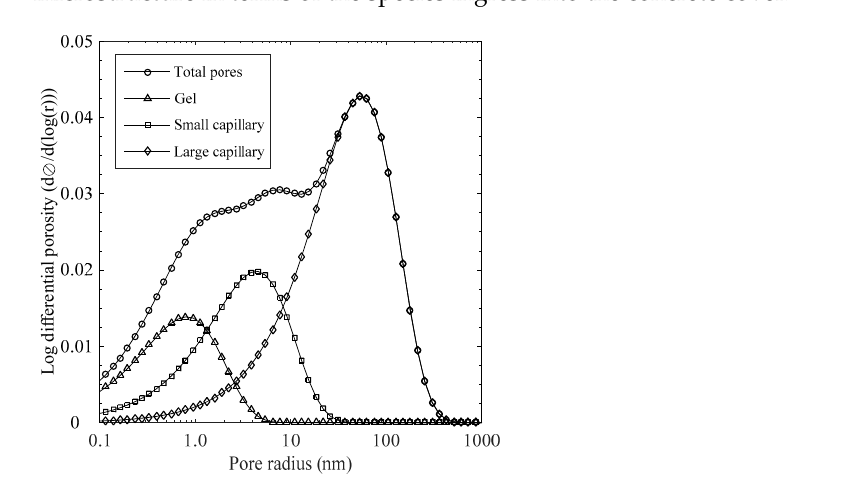
Figure 2. Moisture isotherms under drying and wetting together with saturation radius varying with relative humidity levels.